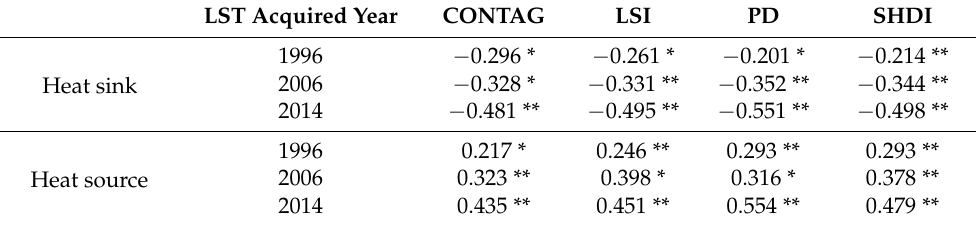
Table 7. Correlation coefficients of landscape pattern of heat sources and heat sinks and LST at the landscape